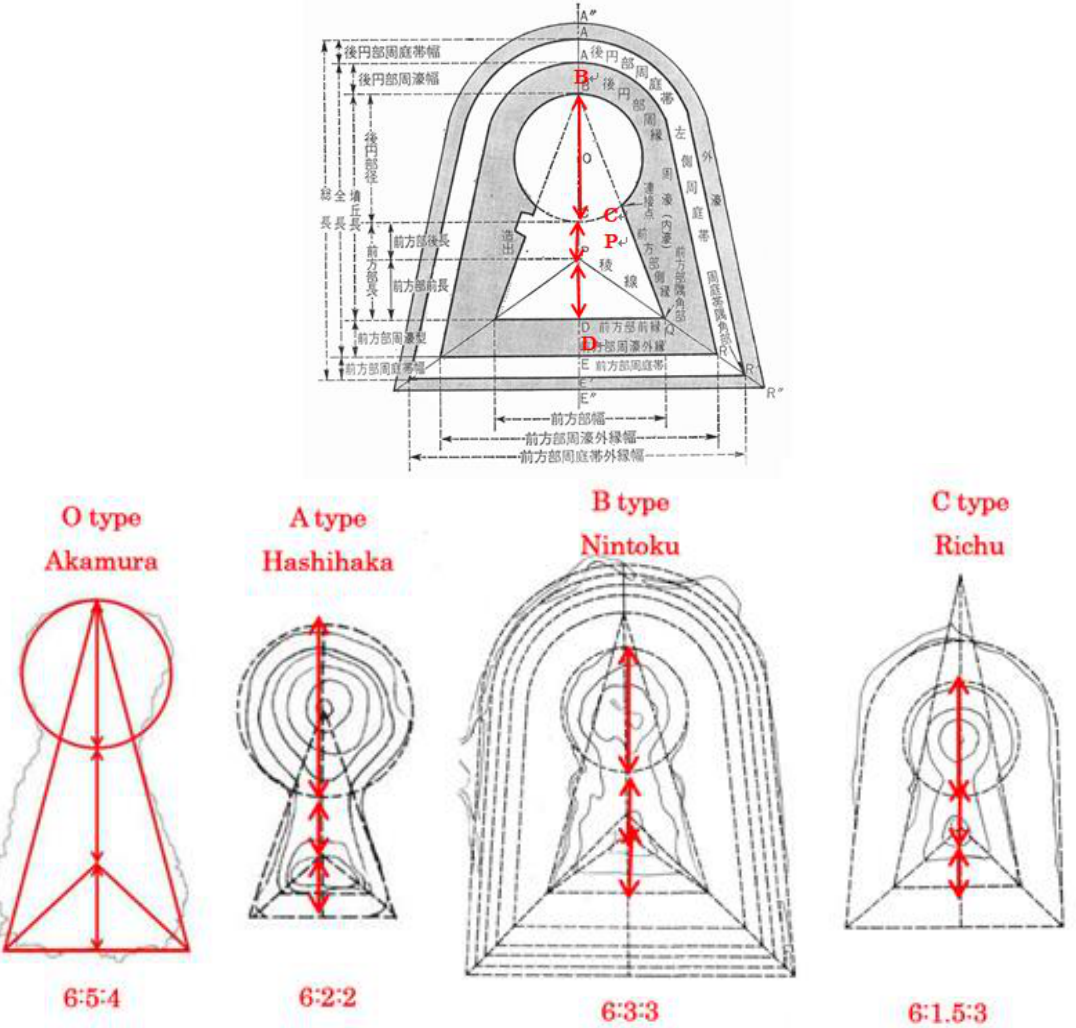
Figure B1. Four types of keyhole mounded tombs by Ueda(1969) classification. Sides BC, CP, and PD are characteristic integers Akamura tomb is O type